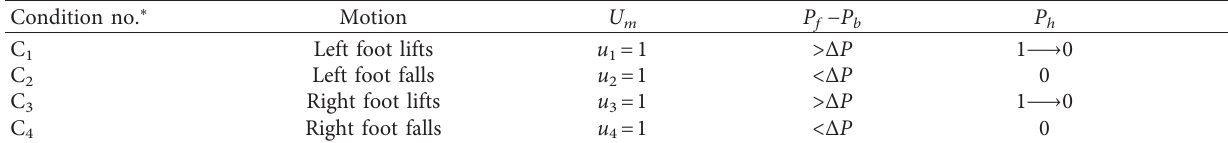
Table 1: The state transition conditions of FSM.